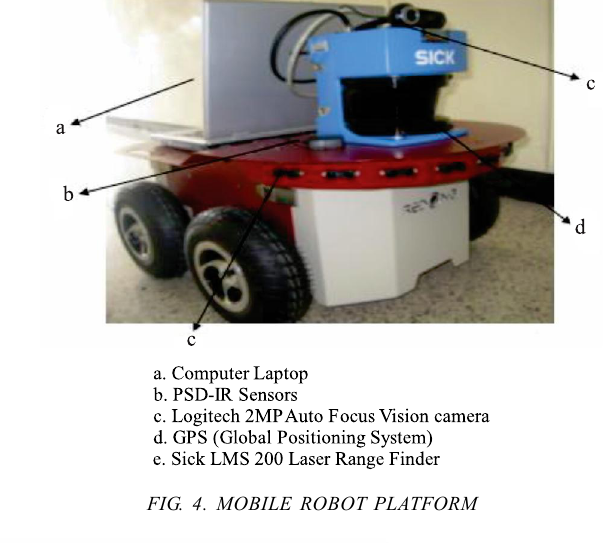
FIG. 4. MOBILE ROBOT PLATFORM